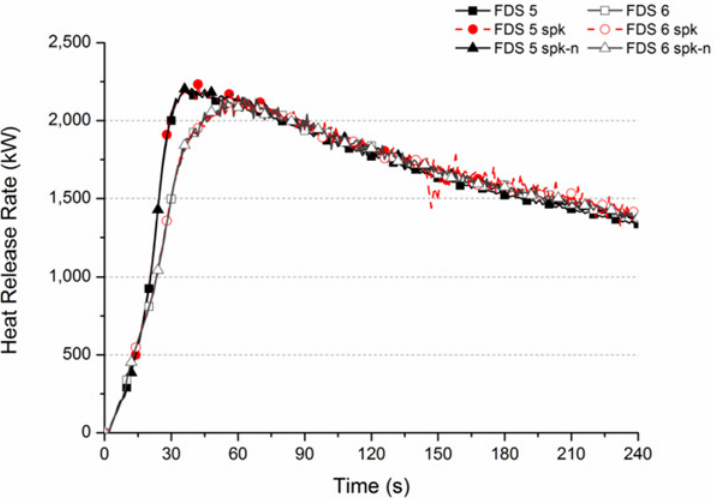
Fig 7. Heat release rate curve of numerical simulation cases.